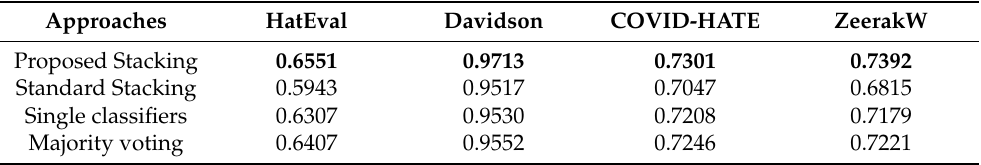
Table 11. Performance of the four hate speech recognition systems in terms of F1-score on tests sets of the four datasets. Bold entries show the highest performance for each classifier on each dataset. Approaches